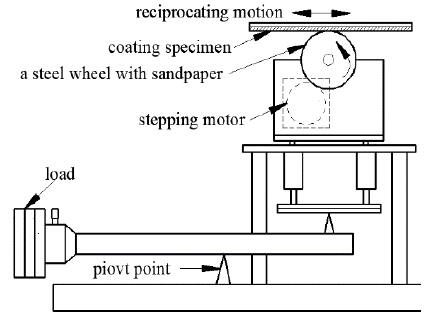
Figure 2. Schematic diagram of the two-body abrasive wear test apparatus.